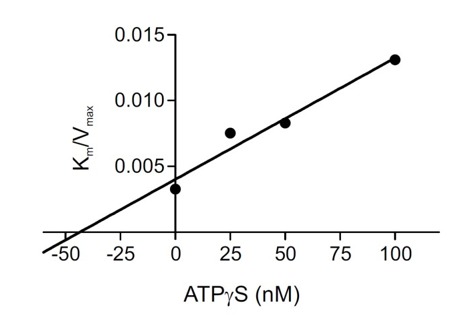
DOI:
http://dx.doi.org/10.7554/eLife.20236.027